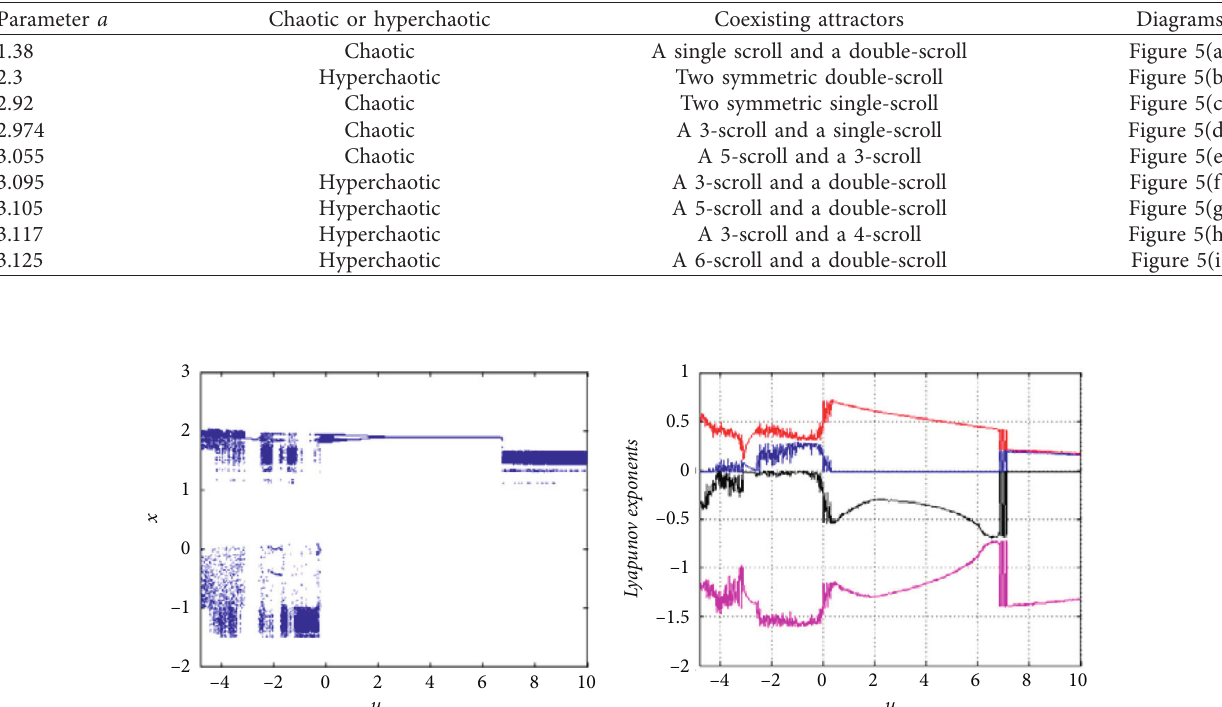
Table 2: The coexisting multiscroll attractors of system (3) with different values of parameter a .